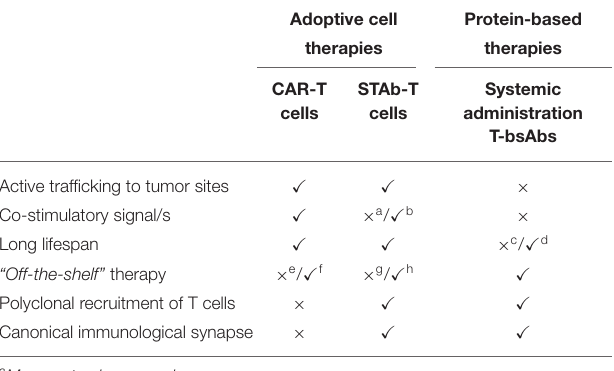
TABLE 1 | Pros and cons of current T cell-redirecting strategies.